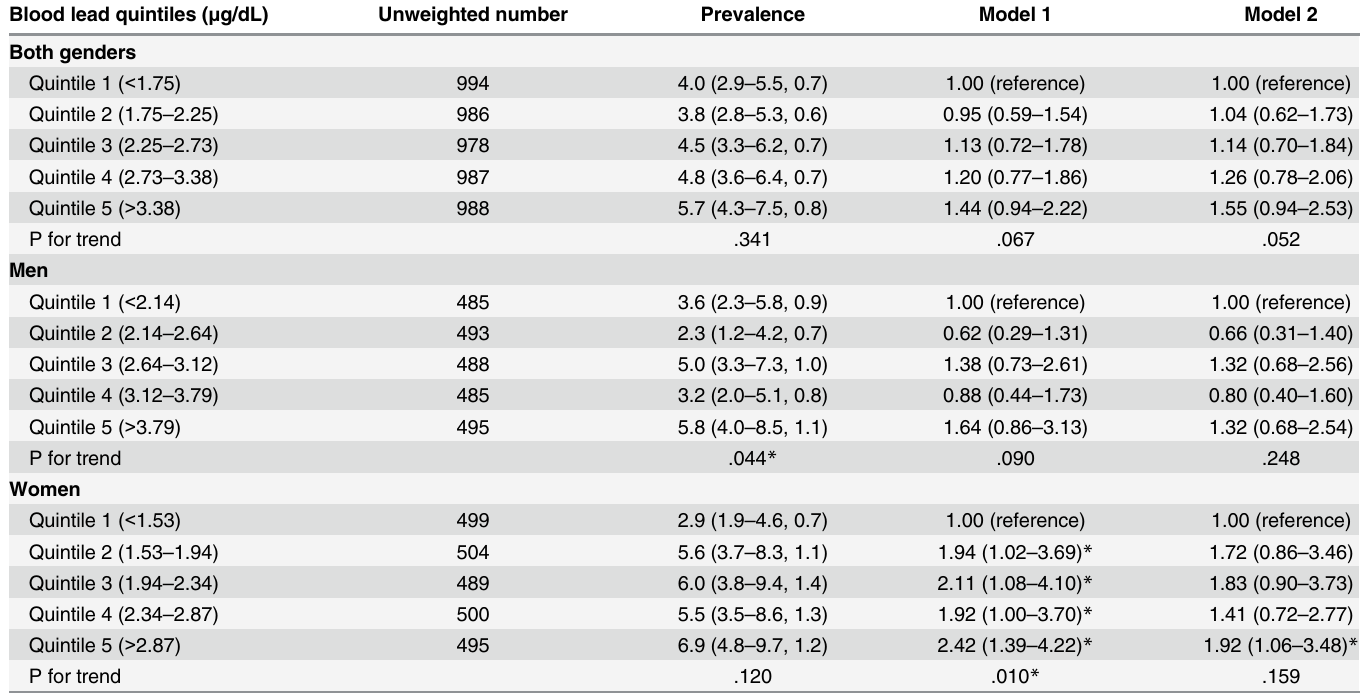
Table 4. Prevalence and adjusted odds ratio of early type of age-related macular degeneration (AMD), stratified according to quintile category of blood lead among representative Korean adults aged 40 years or older included in the study. Prevalence is expressed as weighted estimate [%] (95% confidence intervals, standard errors